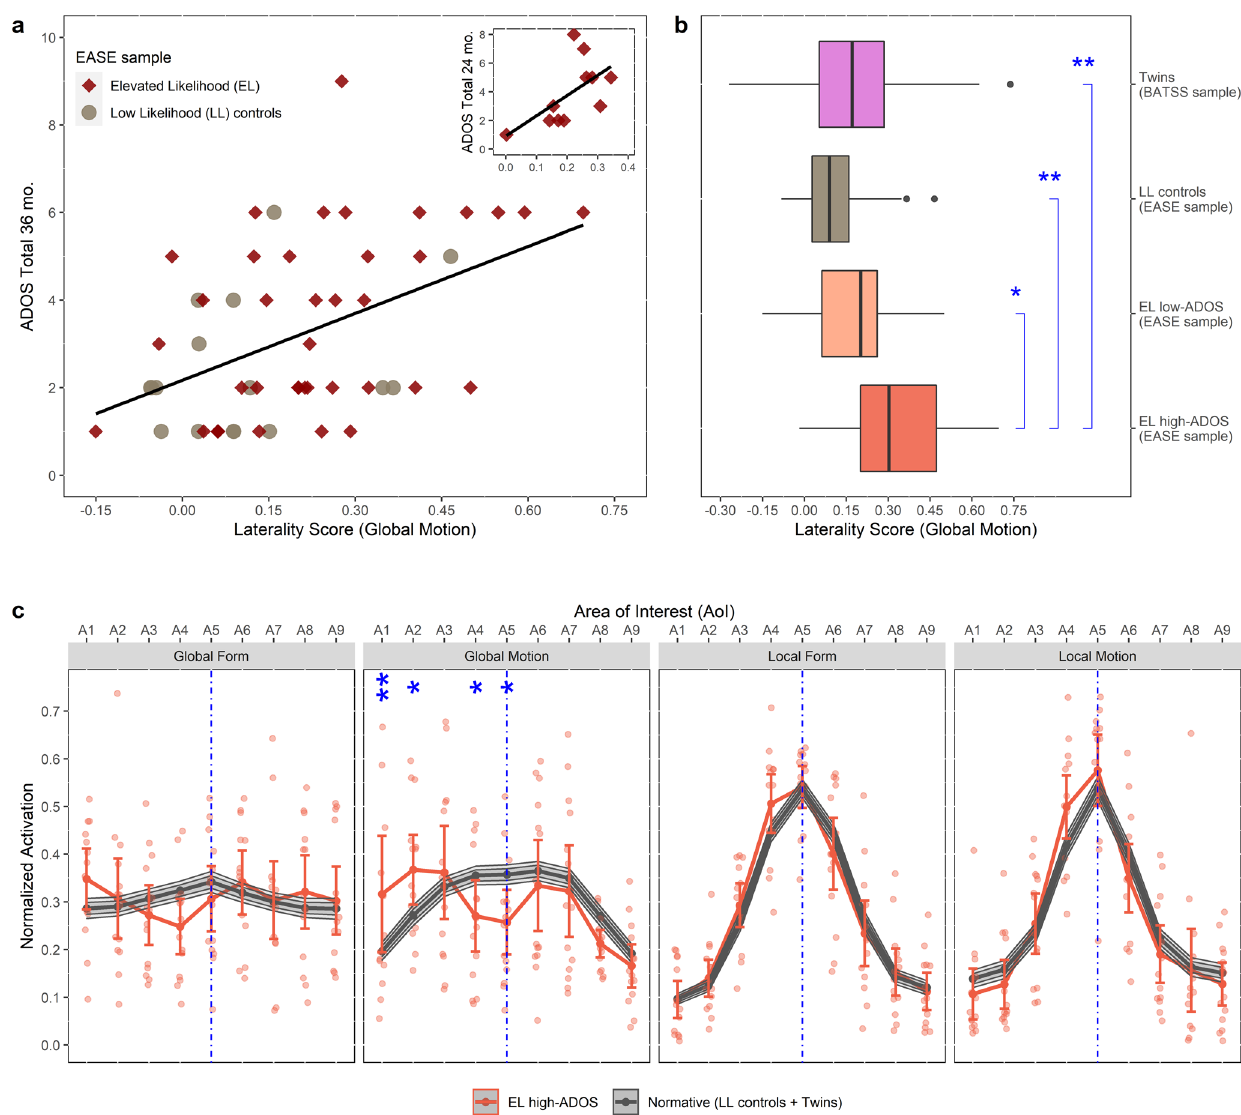
Fig. 2 Topographical organization of global motion processing is different in infants who have high levels of autism symptoms in toddlerhood. a More lateralized activation in the coherent motion condition was associated with higher autistic symptoms (ADOS-2 total scores at 36 months) in the overall EASE sample ( r = 0.465, *** p < 0.001, n = 55), as well as in the EASE EL group ( r = 1.448, ** p = 0.004, n = 39). These were con fi rmed with a linear regression model ( β = 7.22, ** p = 0.005, partial η 2 = 0.170, n = 55) which also revealed no moderation by sex or autism-likelihood group (both p > 0.20). No association was found for the other conditions (all p > 0.25). a inset. Replication in an independent sub-sample of infants at elevated likelihood of autism who partook in ADOS-2 session at 24 months but not at 36 months ( r = 0.596, * p = 0.027, n = 11, one-tailed). b Infants who went on to develop high levels of autistic symptoms at 36 months (EL high-ADOS, n = 14) according to pre-established clinical cut offs (see main text) had more lateralized global motion processing than infants at elevated likelihood with few autistic symptoms (EL low-ADOS: d = 0.25, * p = 0.029, n = 25), infants at low likelihood for autism (LL controls: d = 0.33, ** p = 0.002, n = 16) and the larger community twin sample (BATSS: d = 0.31, ** p = 0.003, n = 452), but no difference was found between these three latter groups (all p > 0.50). Boxplots show the sample median, and the fi rst and third quartiles; whiskers show minimum and maximum (±1.5 s.d.); dots are outliers (±1.96s.d.). Planned group comparisons done with linear mixed model and EMM effect-size analysis. c Comparison of activation across the nine AOIs between the Normative Sample and EL-high ADOS group. During global motion processing, EEG activity in the latter group was characterized by atypically strong extreme left lateral activation (AOIs A1 and A2: M = − 0.120, ** p = 0.009, d = − 0.10 and M = − 0.095, * p = 0.026, d = − 0.08, respectively) and atypically weak midline activation (AOIs A4 and A5: M = 0.085, * p = 0.044, d = 0.07 and M = 0.100, * p = 0.026, d = 0.08, respectively). (Notes: * p < 0.05; ** p < 0.01; *** p < 0.001, for blue asterisks in b and c ; all p values are Benjamini-Hochberg-corrected). Data from the Normative Sample group ( n = 473) is plotted as mean, 95%-C.I. (inner band, darker shade) and 99.5%-C.I. (outer band, lighter shade). Data from the EL high-ADOS group ( n = 14) are plotted as mean & 95%-C.I. (error bars) along with the individual data points (shaded). More detailed activation plots for the Normative Sample are provided in Supplementary Fig. 2. Observe here that con fi dence intervals for the Normative Sample are comparatively very small due to its much bigger sample